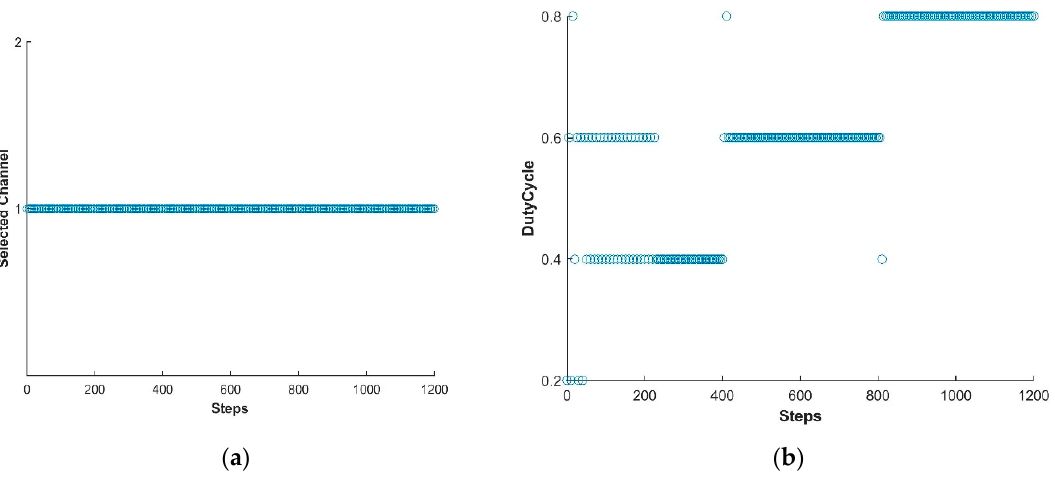
Figure 5. LTE-U BS with DC only method. ( a ) Channel selection vs number of steps; ( b ) Dutycycle selection vs number of steps.